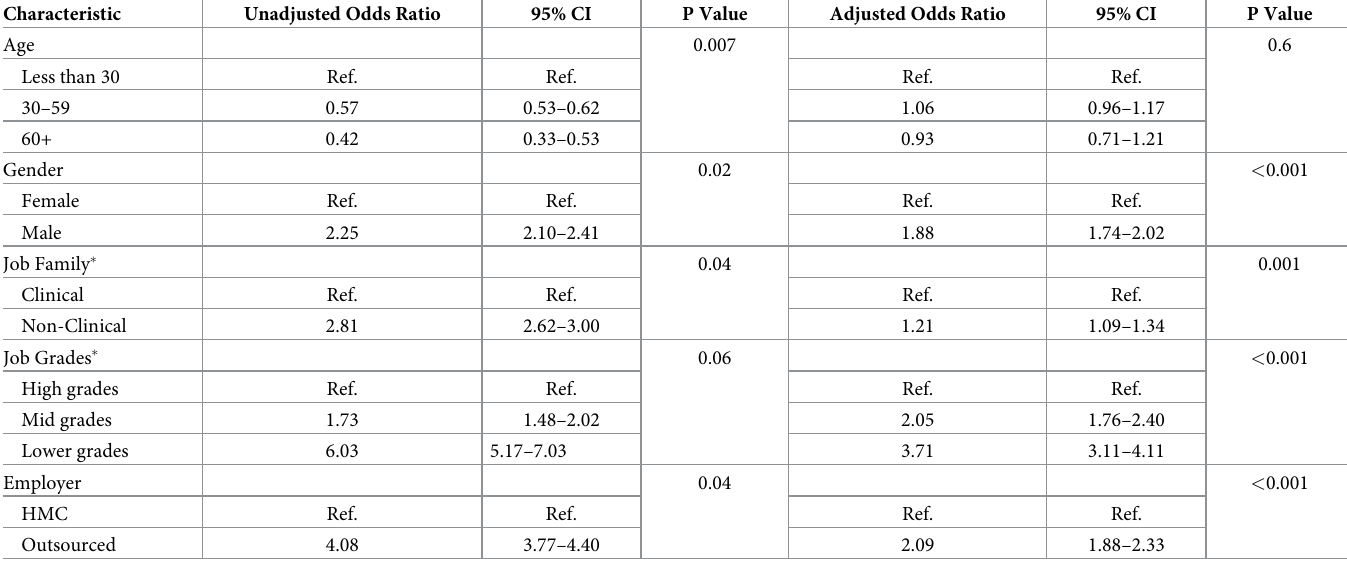
Healthcare workers are presumed to be at a higher risk of infection in a pandemic setting. This belief stems from their dual exposure in the community and in the hospitals. However, we and others have shown a lower incidence and risk of SARS-CoV-2 infection among HCWs [1, 2, 15]. This is most likely due to the heightened awareness and strict infection prevention